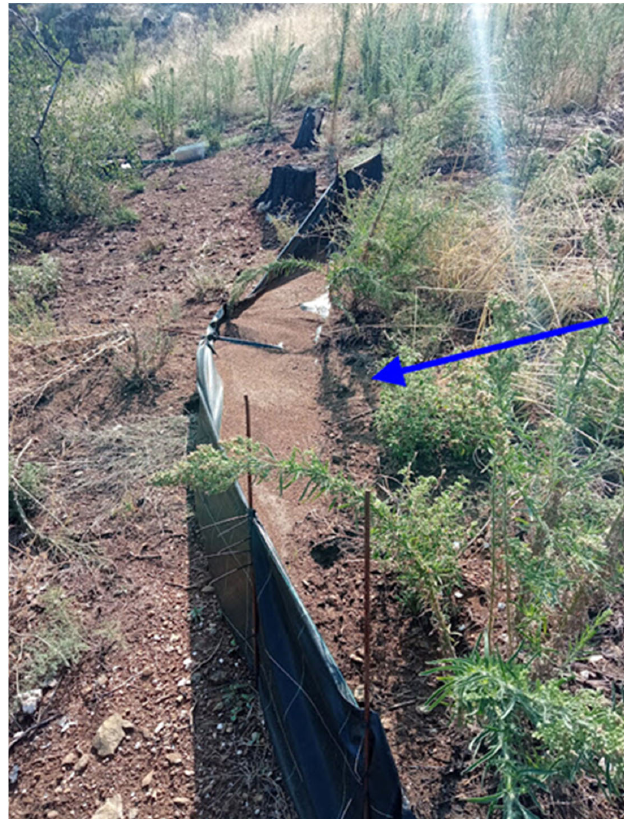
Figure 6. Silt fence operation: the silt fence has bended under the weight of sediment material. The blue arrow indicates the runoff direction. blue arrow indicates the runoff direction.